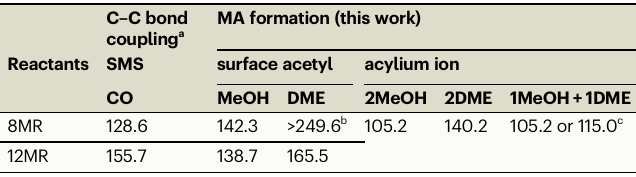
Table 1 | Maximum free energy span (kJ/mol) of MA formation via surface acetyl and DME/MeOH in mordenite at 473 K, as well as acylium ion and DME/MeOH in